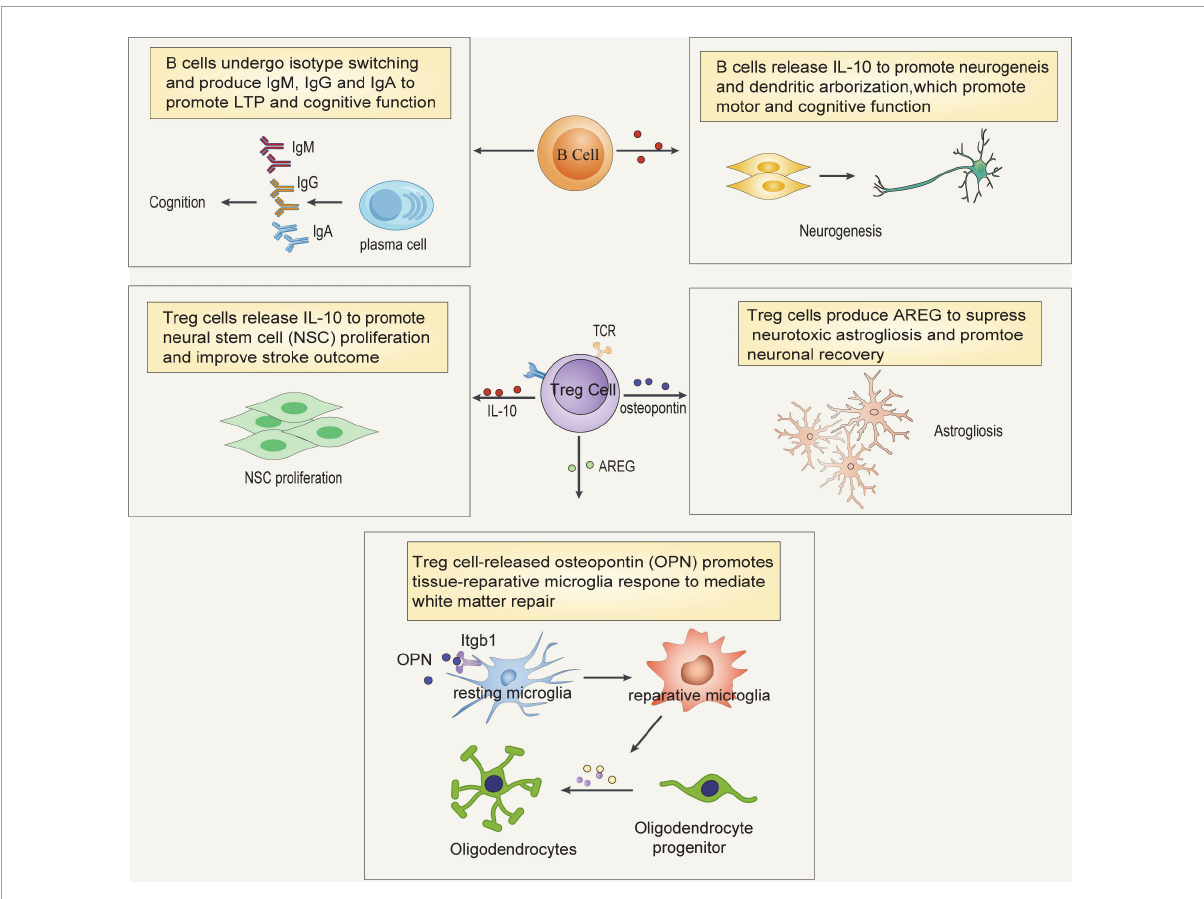
FIGURE4 Mechanisms underlying Treg cell and B cell-mediated impacts on functional recovery after ischemic stroke. Treg cells promotes functional recovery after ischemic stroke by the following means: Treg cells release IL-10 to directly promote neural stem cell proliferation or restrict proinflammatory cytokine production; Treg cells release AREG to inhibit astrogliosis and facilitate neuronal recovery; Treg cell-derived osteopontin act through integrin receptors on microglia to enhance microglial reparative activity, as both anti-inflammatory cytokines and genes encoding proteins involved in brain repair are upregulated, consequently facilitating oligodendrocyte regeneration and white matter integrity. B cells release IL-10 to promote neurogenesis and dendritic arborization, which promote motor and cognitive function, and in addition, B cells also undergo isotype switching and produce IgM, IgG and IgA to promote cognitive function. TCR, T cell receptor; ILRs, interleukin receptors; AREG, amphiregulin; NSC, neural stem